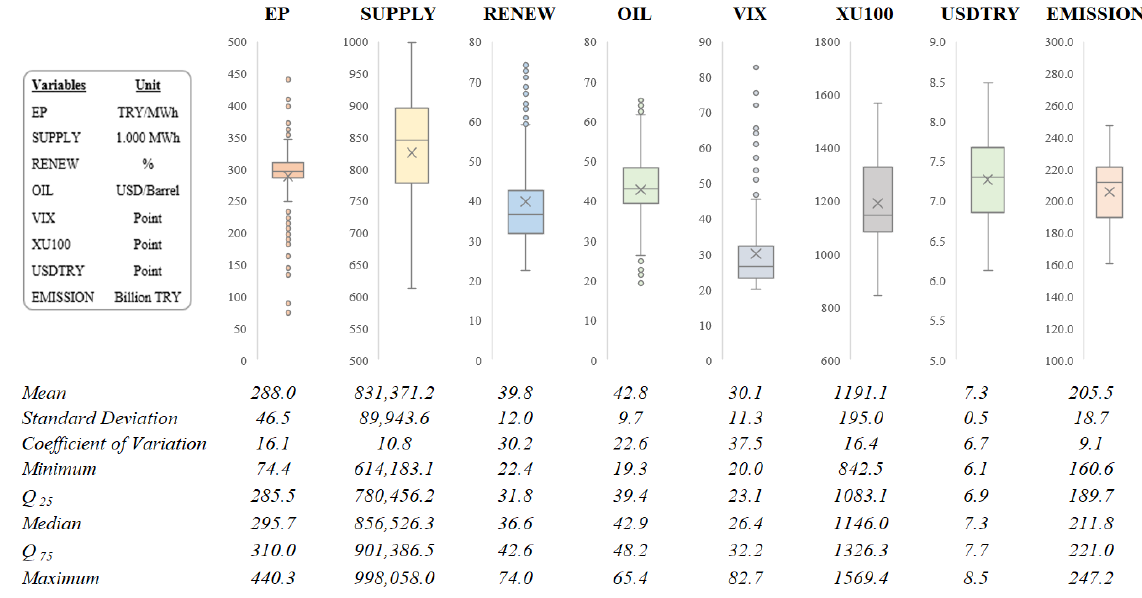
Figure 3. Descriptive statistics in the pandemic period (11 March 2020–31 March 2021).